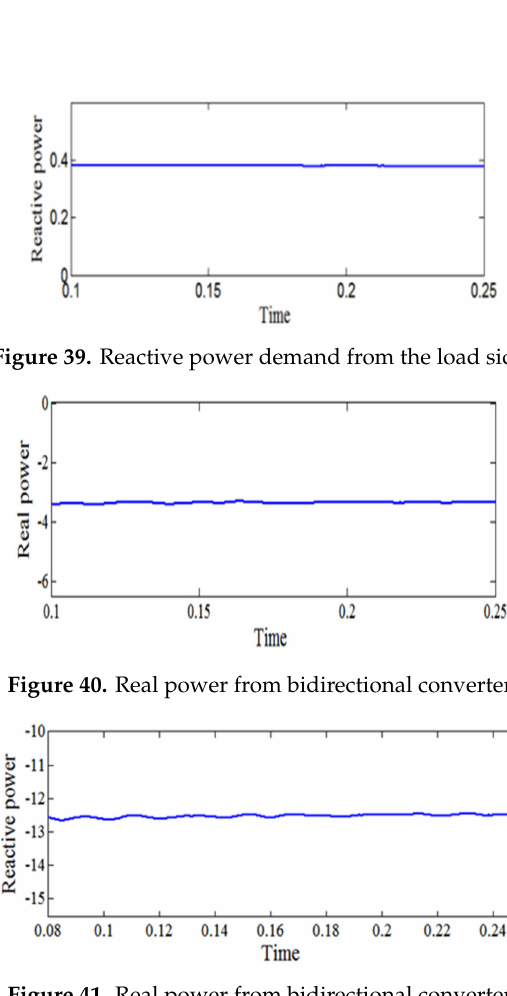
Figure 41. Real power from bidirectional